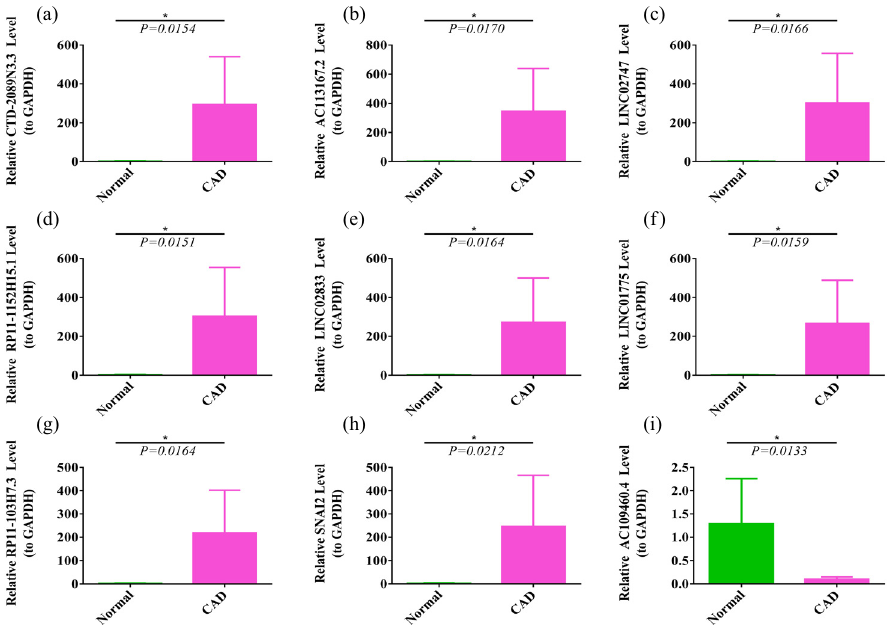
Figure 9: The relative expression of eight EMT - related lncRNAs and SNAI2 in the validation cohort: ( a ) CTD - 2089N3.3, ( b ) AC113167.2, ( c ) LINC02747, ( d ) RP11 - 1152H15.1, ( e ) LINC02833, ( f ) LINC01775, ( g ) RP11 - 103H7.3, ( h ) SNAI2, and ( i )